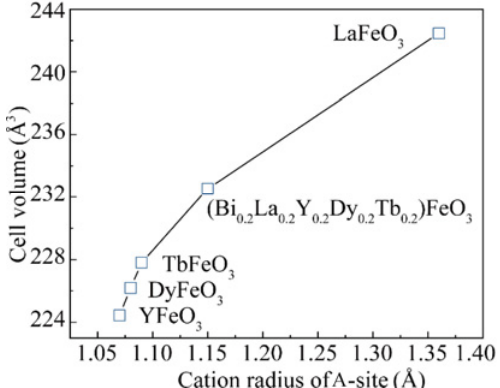
Fig. 4 Relationship between ionic radius of A-site and cell volume.